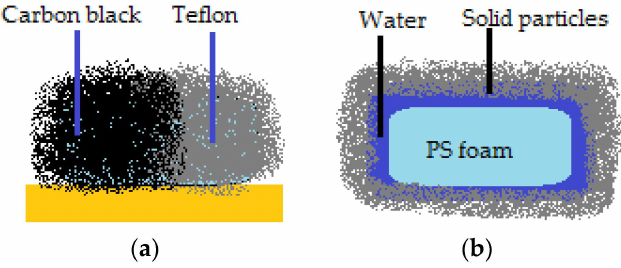
Figure 2. ( a ) Liquid marble resembling a Janus particle; ( b ) Cubic FPS